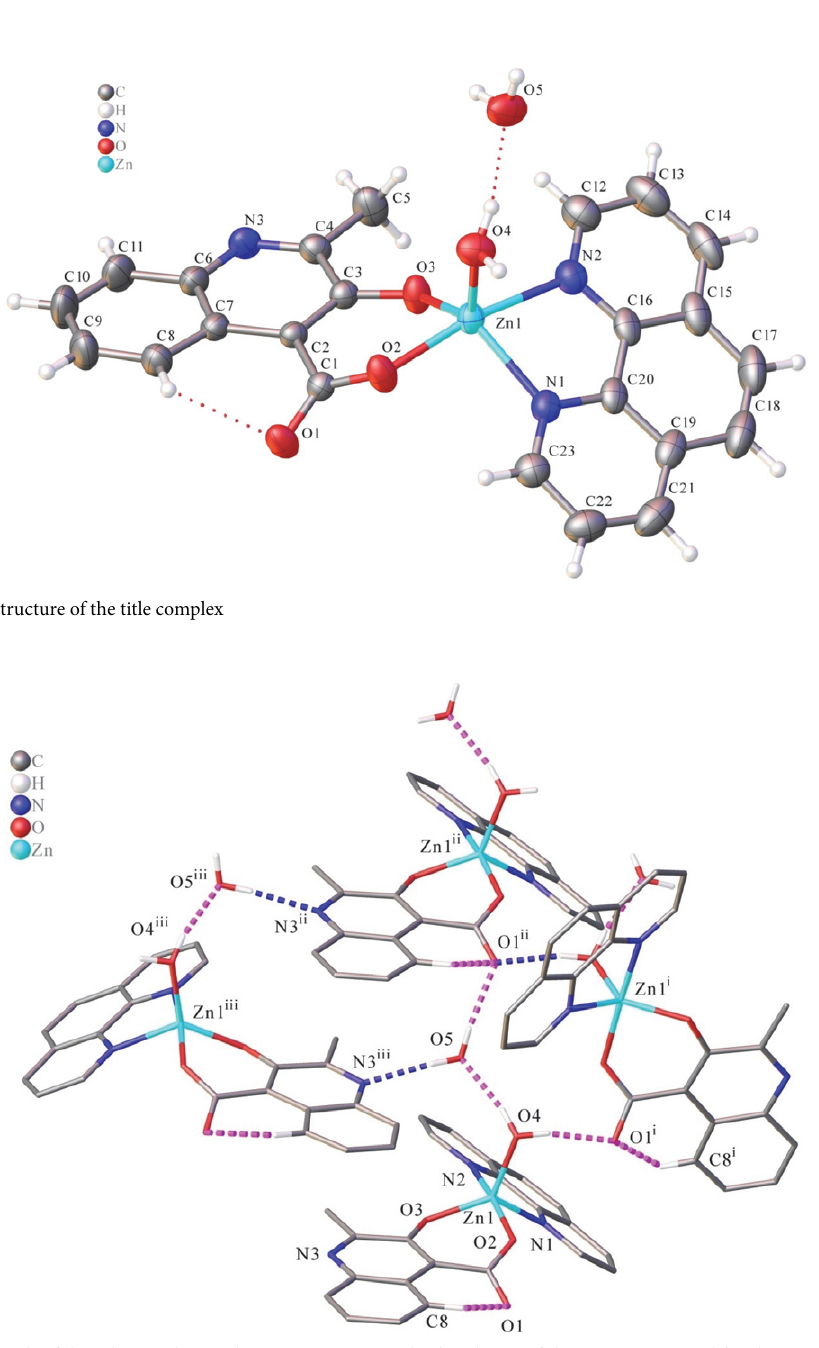
Fig. 2. The hydrogen bonds of the title complex. Hydrogen atoms not involved in the motif shown were removed for clarity. Symmetry codes: (i) ½ + x , 3 / 2 – y , 1 – z ; (ii) 1 + x , y , z ; (iii) ½ + x , y , ½ – z